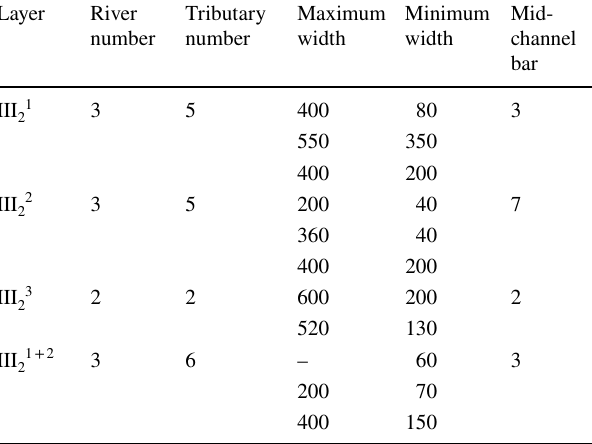
Table 2 River feature of III oil-bearing interval of Sanggonghe For- mation in Baobei District, Yanqi